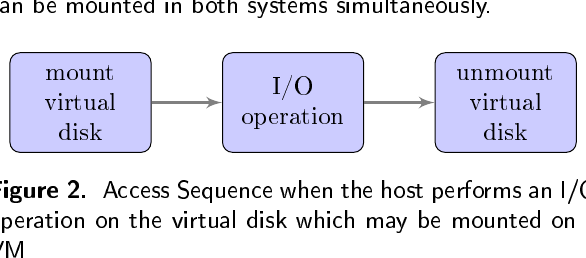
Figure 1. The virtual disk containing the shared directory can be mounted in both systems simultaneously.